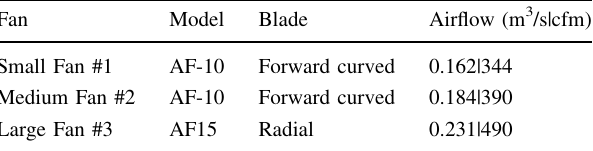
Table 14 Average amount of air supplied to the plenum by fan type